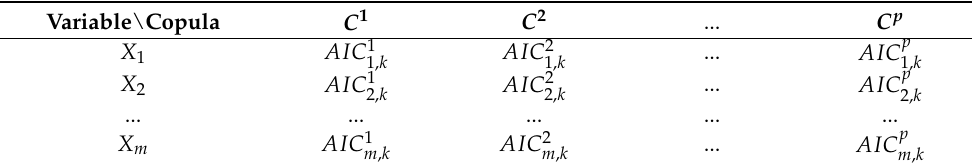
Table 1. AIC calculated by pair (variable/copula). Variable \